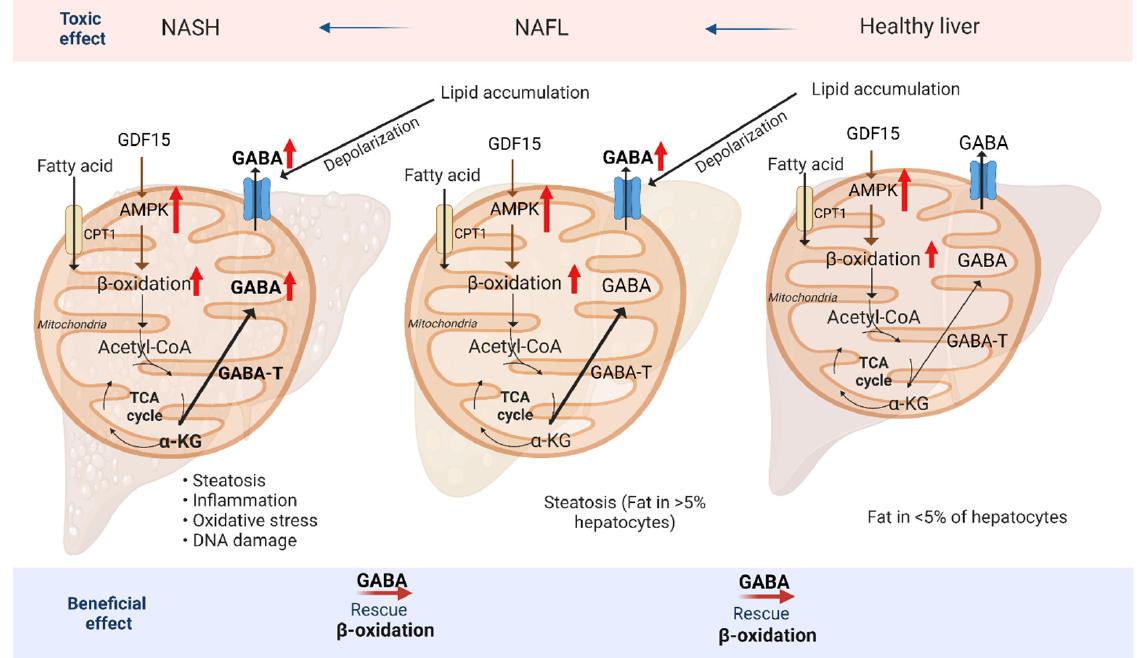
Figure 3. GABA and fa tt y acid metabolism reduce the symptoms of liver disease. Schematic repre- sentation of dysfunction of lipid metabolism, which is linked to non-alcoholic fa tt y liver disease (NAFLD, NAFL). Growth di ff erentiation factor 15 (GDF15) activates 5 ′ -AMP-activated protein linase (AMPK) pathway to increase fa tt y acid oxidation (FAO, b-oxidation), which directly a ff ects the accumulation of fa tt y acid in non-alcoholic steatohepatitis (NASH). Activation of FAO decreases oxidative stress and DNA damage in NASH and NAFL to a healthy liver. Moreover, GABA transaminase (GABA-T) converts alpha-ketoglutarate (a-KG) to gamma-aminobutyric acid (GABA), suggesting GABA directly regulates membrane potential in liver. Lipid accumulation in liver dis- ease induces hepatocyte membrane depolarization and increases GABA out fl ow, which leads to hyperinsulinemia and aggravates the symptoms of NASH and NAFL.